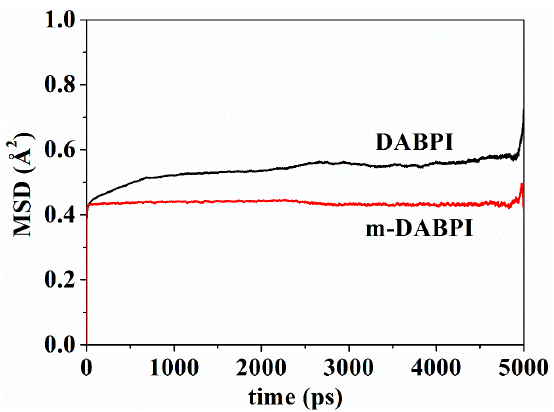
Figure 9. MSD of polymer chains as a function of time in DABPI and m-DABPI.